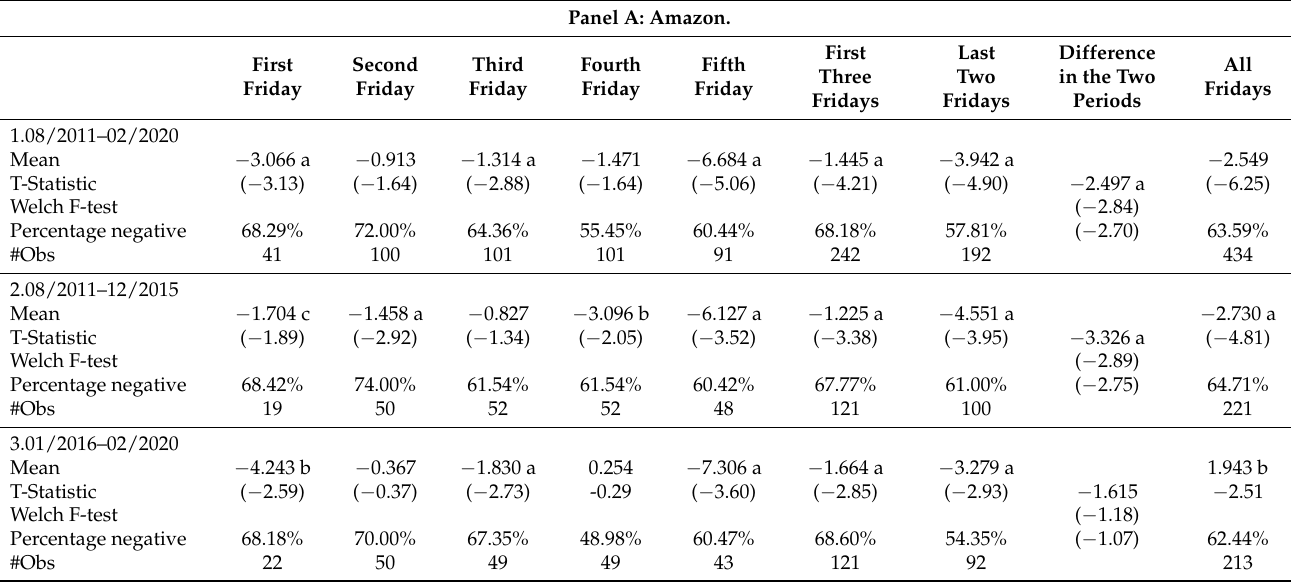
Table 6. Summary statistics for the Friday return categorized by week. Panel A: